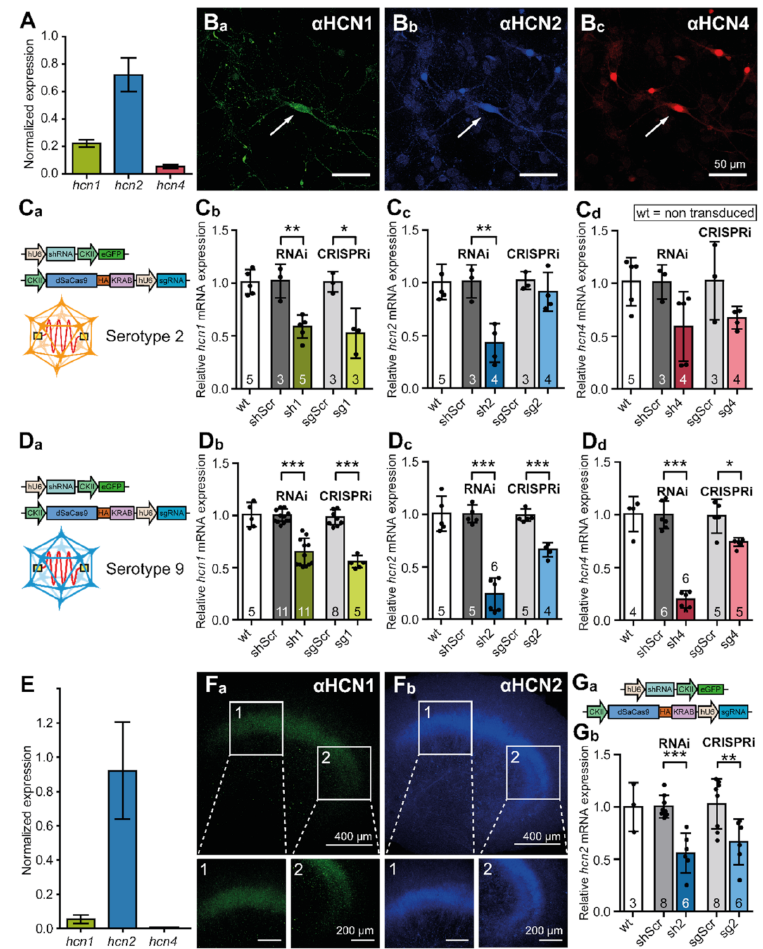
Figure 4. RNAi and CRISPRi reduce the amount of HCN channel transcripts in PHNs and OHSCs. ( A ) qRT-PCR analysis of transcript expression levels for HCN isoforms 1, 2, and 4 in primary hip- pocampal neurons (PHNs). Transcript expression levels were normalized to gapdh. Values shown are calculated to 1 as the sum of all hcn transcripts. cDNA was prepared from 5 coverslips with PHNs from at least three different animals. ( B a – B c ) Representative immunofluorescence images showing expression of HCN-channel isoforms 1 (green), 2 (blue) and 4 (red). Isoforms were stained using specific antibodies combined with fluorescently labeled secondary antibodies. ( C a ) Schematic representation of constructs delivered by rAAV2 to PHNs. ( C b – C d ) qRT-PCR analysis of hcn1 , hcn2 , and hcn4 mRNA levels in hippocampal neurons after transduction with shRNA or sgRNA/dSaCas9 expressing rAAVs. ( D a ) Schematic representation of constructs delivered by rAAV9 to PHNs. ( D b – D d ) qRT-PCR analy- sis of hcn1 , hcn2 , and hcn4 mRNA levels in hippocampal neurons after transduction with shRNA or sgRNA/dSaCas9 expressing rAAVs. ( E ) qRT-PCR analysis of transcript expression levels for HCN isoforms 1, 2, and 4 in organotypic hippocampal slice cultures (OHSCs). The transcript expression levels were normalized to gapdh. Values shown are calculated to 1 as the sum of all hcn transcripts. cDNA was prepared from five culture inserts, each containing three individual slices. In total, slices were obtained from three different animals. ( F a , F b ) Representative immunofluorescence images showing the expression of HCN-channel isoforms 1 (green) and 2 (blue). The isoforms were stained using specific antibodies. Enlargements show HCN-isoform expression in hippocampal CA1 (1) and CA3 (2) subfields. ( G a , G b ) qRT-PCR knock-down analysis of hcn2 mRNA levels in organotypic slices after transduction with shRNA or sgRNA/dSaCas9 expressing rAAV9. The data were obtained from indicated numbers of culture inserts, each containing three individual slices. In total, slices were obtained from at least three different animals. The results are depicted as mean ± standard deviation. Statistical significance was assessed using the unpaired two-tailed Student’s t test, * p < 0.05, ** p < 0.01, *** p <